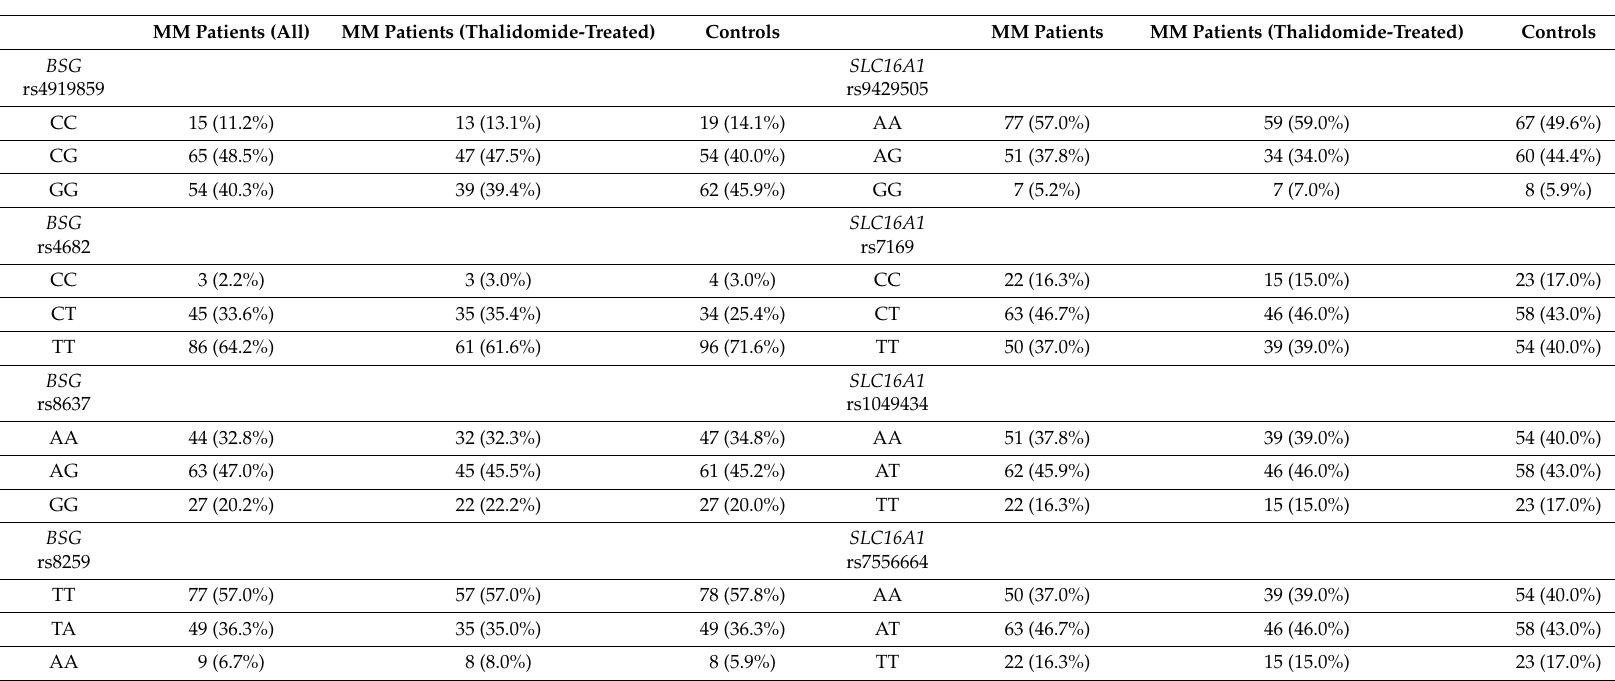
Table 1. Distribution of BSG and SLC16A1 genotypes in multiple myeloma (MM) patients (entire patient cohort and thalidomide-treated patients only) and healthy